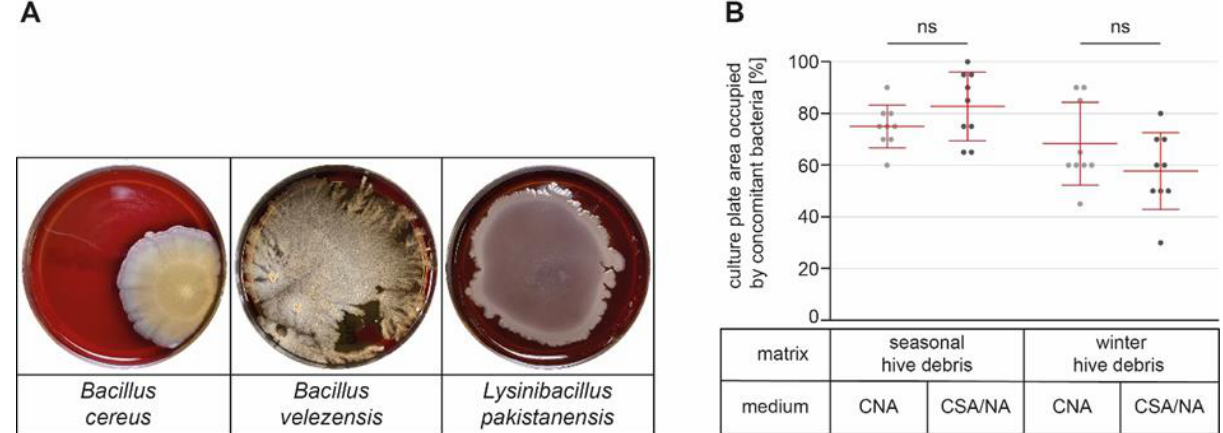
Figure 2. Reducing the growth of concomitant bacteria in debris samples with nalidixic acid. ( A ) Representative pictures of Bacillus cereus , B. velezensis , and Lysinibacillus pakistanensis after six days of culture on CSA plates at 37 °C are shown. ( B ) Samples of seasonal and winter hive debris were each cultivated on CNA plates (CNA) and on CSA plates supplemented with 10 µ g/mL nalidixic acid (CSA/NA). The proportion of the culture plate occupied with concomitant bacteria was estimated. Scatter plots show nine samples per matrix and culture medium, as well as the mean values ± SDs of the nine independent samples per group. Data were analyzed by unpaired Student’s t -testing with Welch’s correction, and there were no statistically significant ( p > 0.05) differences between CNA and CSA/NA for both sample types.